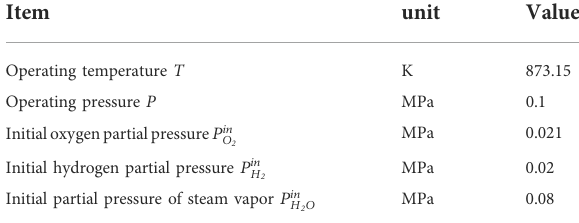
TABLE 2 The boundary conditions of the